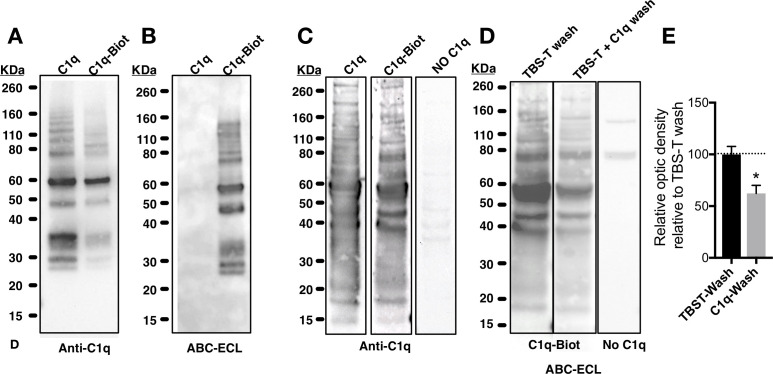
Biochemical analysis of C1q and biotinylated-C1q.(A) Western blot of purified unmodified C1q (C1q) and biotinylated C1q (C1q-Biot) using anti-C1q antibody. (B) Gel electrophoresis of C1q and C1q-Biot demonstrates that avidin-biotin-peroxidase complex (ABC) (Vector Laboratories) followed by enhanced chemiluminescence (ECL) reaction with horseradish peroxidase (HRP) substrate recognizes only biotinylated C1q. (C-E) C1q and C1q-Biot show similar interaction patterns in far-western blot. (C) Far-westernblot reveals similar binding patterns of naive (C1q, left panel) or biotinylated C1q (C1q-Biot, middle panel) with proteins from hNSC total protein lysates. Control membranes were incubated without C1q (No C1q, right panel). Bound C1q was identified by immunodetection. (D-E) Competitive binding of biotinylated-C1q and naive-C1q demonstrates interaction specificity. (D) Far-westernblot was performed with hNSC total protein lysates and C1q-Biot. Membranes were then differentially washed with either TBS-T (control) or TBS-T + unmodified C1q, to compete with C1q-Biot for protein interactions. Bound C1q-Biot was identified by ABC-ECL reaction. Control membranes were incubated without C1q (right panel). (E) Relative optical density analysis reveals that washes with unmodified-C1q decreased C1q-Biot binding indicating the specificity of the interaction. Data show mean ± SEM of bound C1q relative optic intensity normalized to control (TBS-T washes; dashed line). Statistical analysis using one-sample t-test for comparison with control (*p=0.0398).